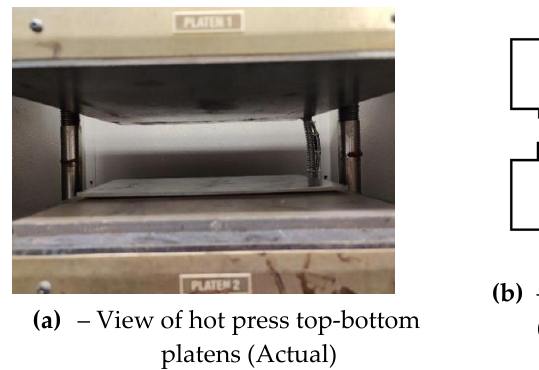
Figure 5. Pictorial and schematic of the hot press and key components for MLR studies.